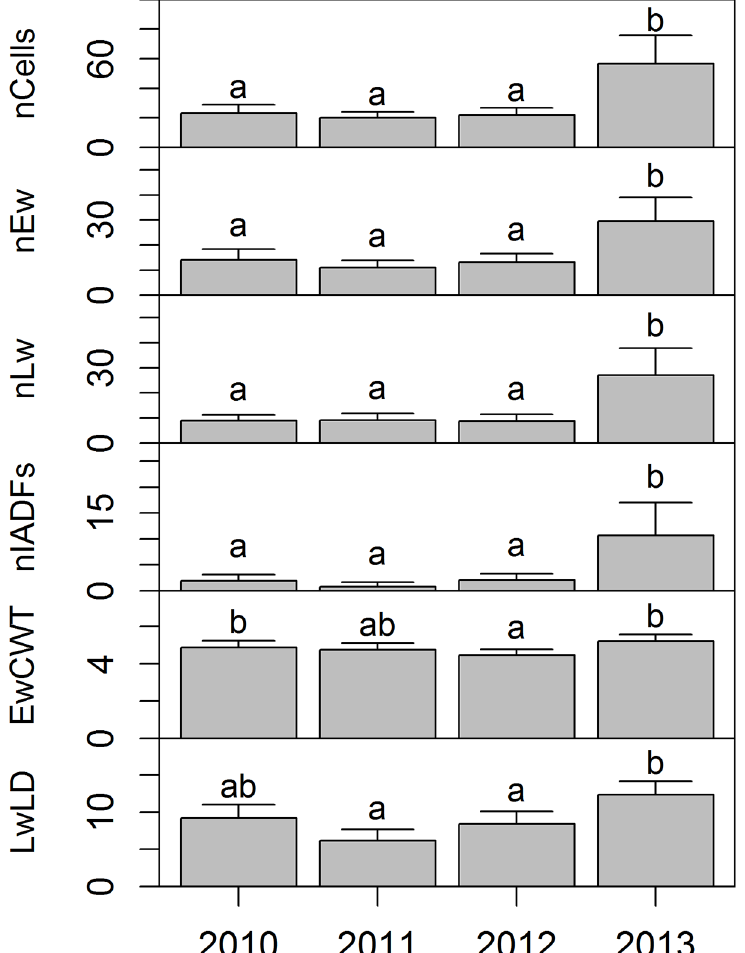
Fig 3. Temporal variation of different anatomical variables for the period 2010 – 2013. Anatomical variables: number of cells (nCells), number of earlywood tracheids (nEw), number of latewood tracheids (nLw), number of earlywood-like tracheids within the latewood (nIADFs), cell wall thickness of the earlywood (EwCWT) and lumen diameter of latewood (LwLD). Data are the means ± 2SE and different letters indicate significant differences between